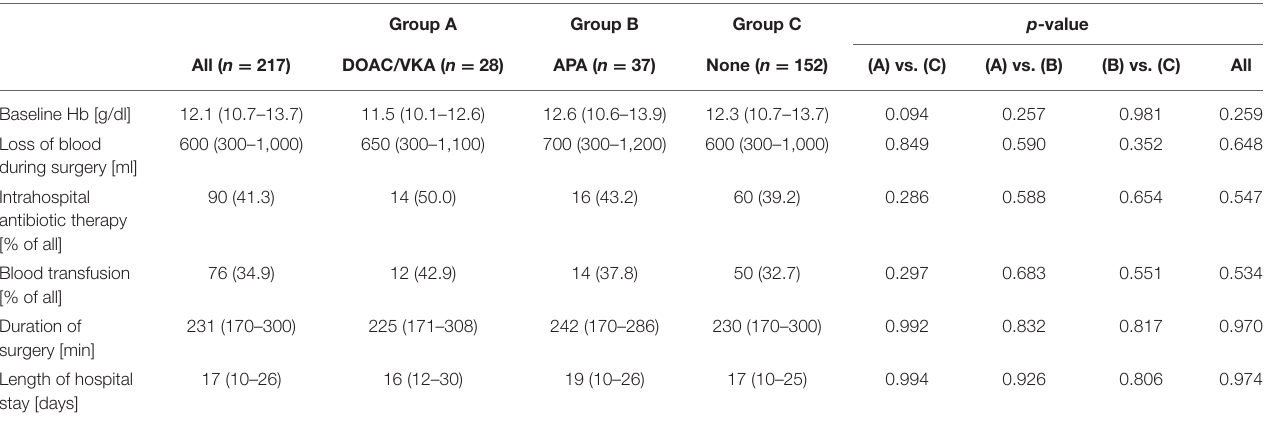
TABLE 2 | Differences in surgical